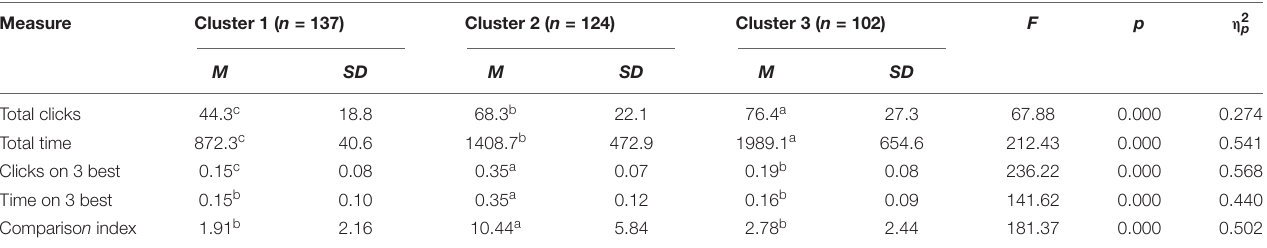
FIGURE 1 | Pairs plot of cluster variables. Cluster 1 (red): low effort - low focus, cluster 2 (green): moderate effort - high focus, cluster 3 (blue): high effort - low focus; lower left: scatter plots split by clusters; diagonals: density plots comparing clusters; upper right: correlation coefficients per cluster, where * p < 0.05, ** p < 0.01, *** p < 0.001. TABLE 2 | Means, Standard Deviations and results of the ANOVA’s on the behavioral measures of information